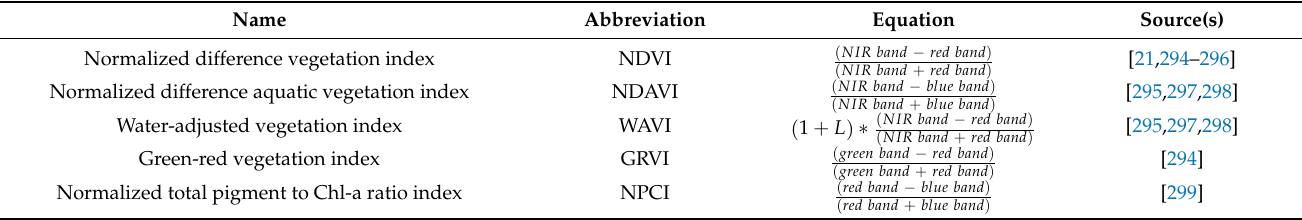
Table 3. A selection of SVIs of interest in SAV studies, whether due to their popularity, target material or use. Their full names, abbreviations, equations and sources that use each are listed. L represents a water column correction factor determined for a specific